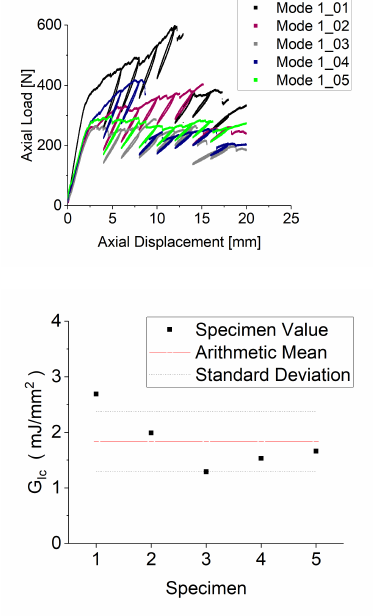
Figure 10. Results: load over displacement (top) and mode I fracture toughnesses comparison (bottom)